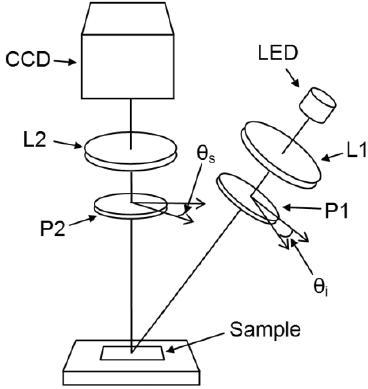
Fig. 1. Schematic of the RLPI system, P: polarizer, L: lens. P1 and P2 can be rotated around their optical axes to vary the polarization angles for both incidence ( (cid:1) i ) and detection ( (cid:1) s ).